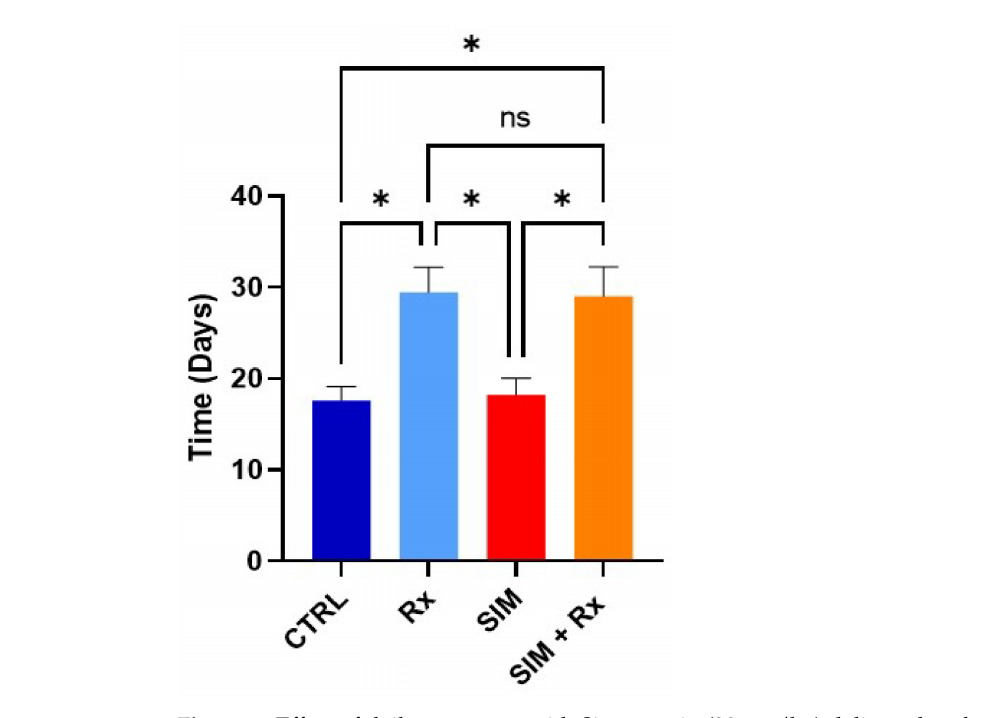
Figure 6. Effect of daily treatment with Simvastatin (20 mg/kg) delivered at the time of maximal tumor reoxygenation on PC-3 tumor growth. Data are shown as means ± SEM of tumor growth to achieve a 1200 mm 3 tumor volume. (*) p < 0.05, two-way ANOVA n =